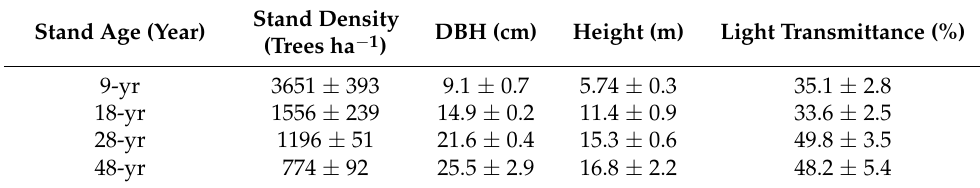
Table 1. Stand characteristics in different age groups in P. massoniana plantation in the study area. Values are presented as mean ± standard deviation. DBH: Diameter at breast